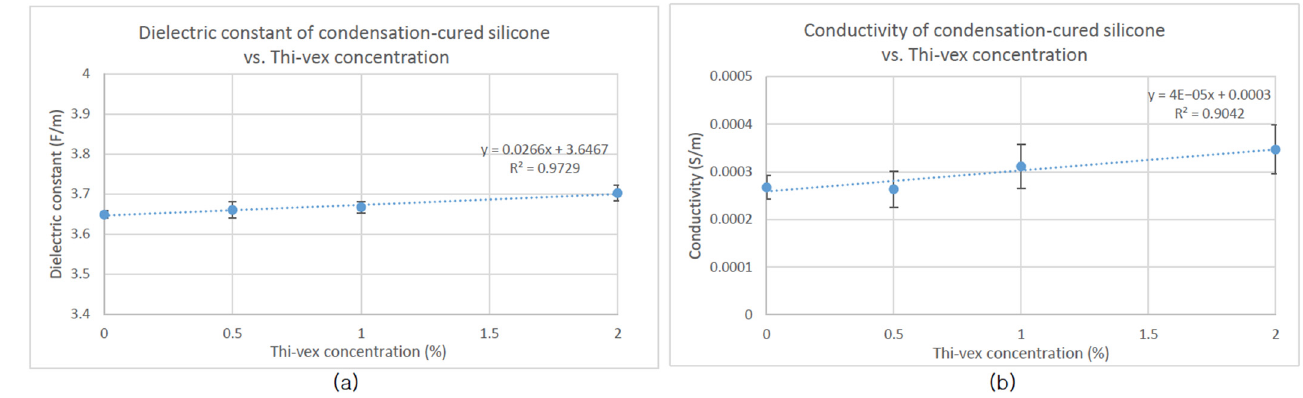
Figure 1. Dielectric properties of platinum-cured silicone samples relative to Slacker and Thi-vex concentrations. ( a ) Die- lectric constant of platinum-cured silicone with various Thi-vex concentrations relative to Slacker ratio. ( b ) Dielectric con- stant of platinum-cured silicone at various Slacker ratios relative to Thi-vex concentrations. ( c ) Conductivity of platinum- cured silicone with various Thi-vex concentrations relative to Slacker ratio. ( d ) Conductivity of platinum-cured silicone at various silicone:Slacker ratios relative to Thi-vex concentration.